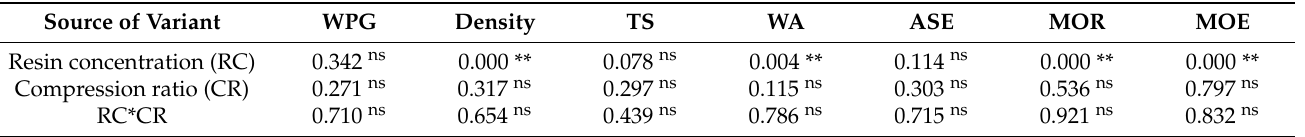
Table 5. Summary of analysis of variance (ANOVA) at p ≤ 0.05 of the interaction between processing parameters and properties of laminated compreg